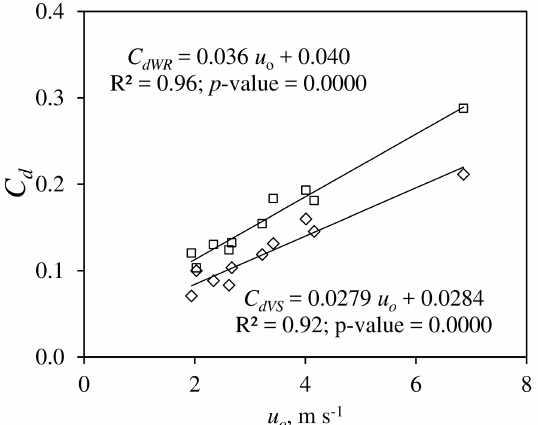
Figure 6. Discharge coefficients of side vents C dVS ( ◊ ) and roof vent C dWR ( □ ), obtained for each test, expressed as a function of air velocity u o .